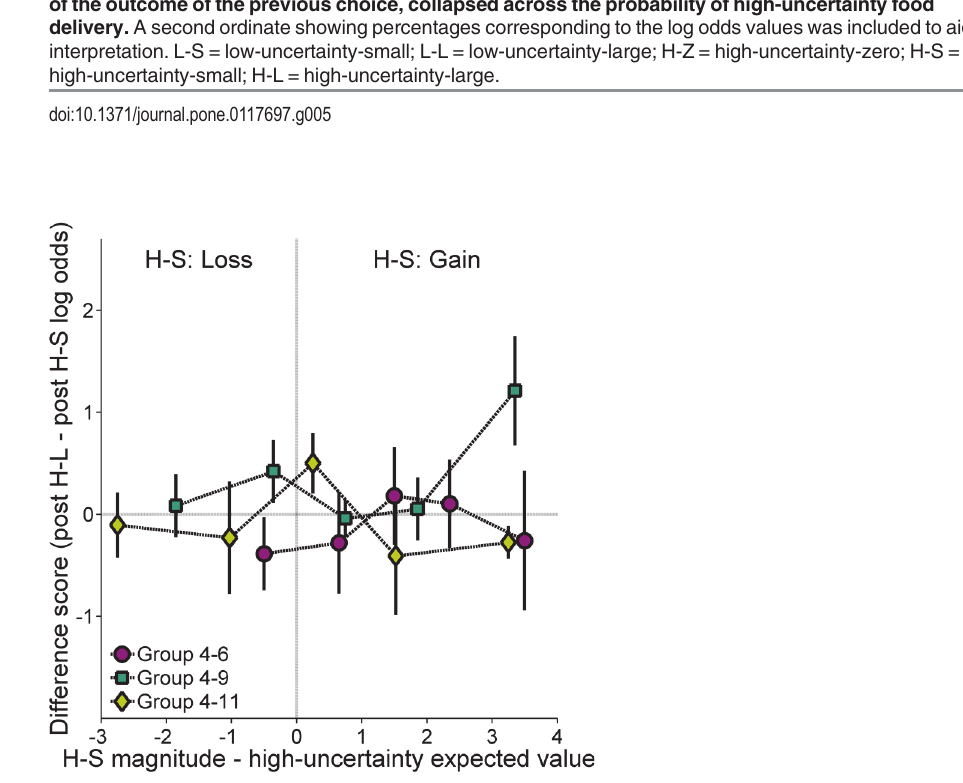
Fig 6. Mean ( ± SEM) difference score between the log odds of high-uncertainty choices following high- uncertainty-large (H-L) outcomes and the log odds of high-uncertainty choices following high- uncertainty-small (H-S) outcomes for each group in Experiment 2 as a function of the difference between the magnitude of the H-S outcome and the expected value of the high-uncertainty choice. A negative/positive difference on the abscissa indicates that the H-S outcome magnitude was greater than/less than the expected value of the high-uncertainty choice (gain/loss, respectively). A negative or positive difference on the ordinate reflects a greater likelihood to make high-uncertainty choices following H-S or H-L outcomes,